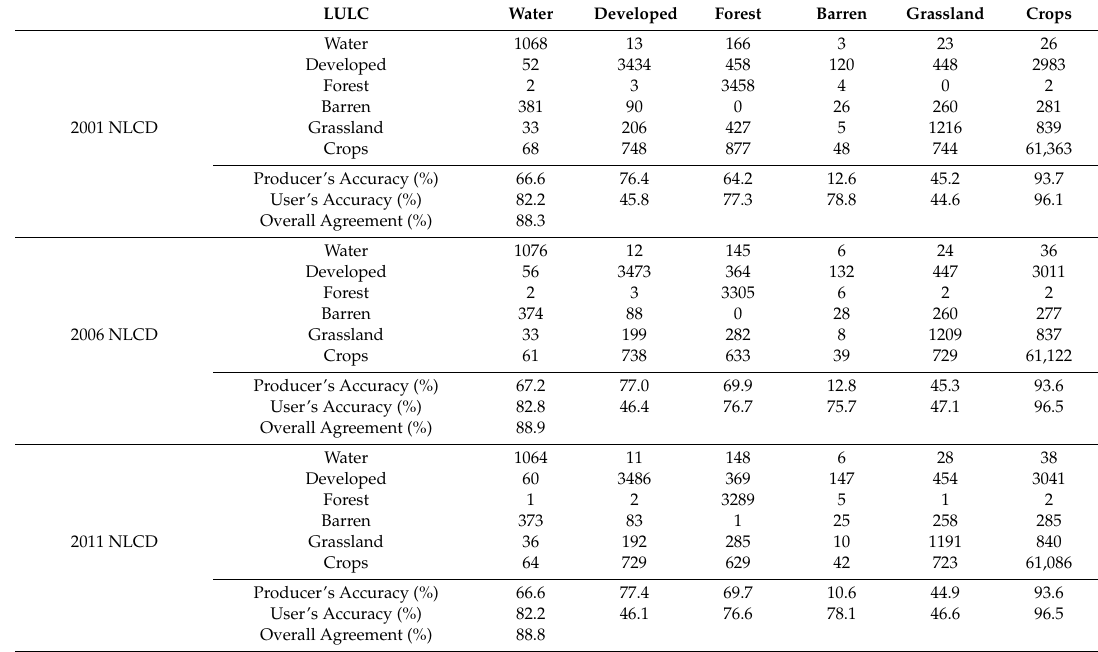
Table 2. Peoria footprint confusion matrix contrasting agreement between the three NLCD validation datasets. Overall agreement was consistently ~89%. Note that units are counts of 30 × 30 m pixels, except Producer’s and User’s Accuracy and Overall Agreement, which are